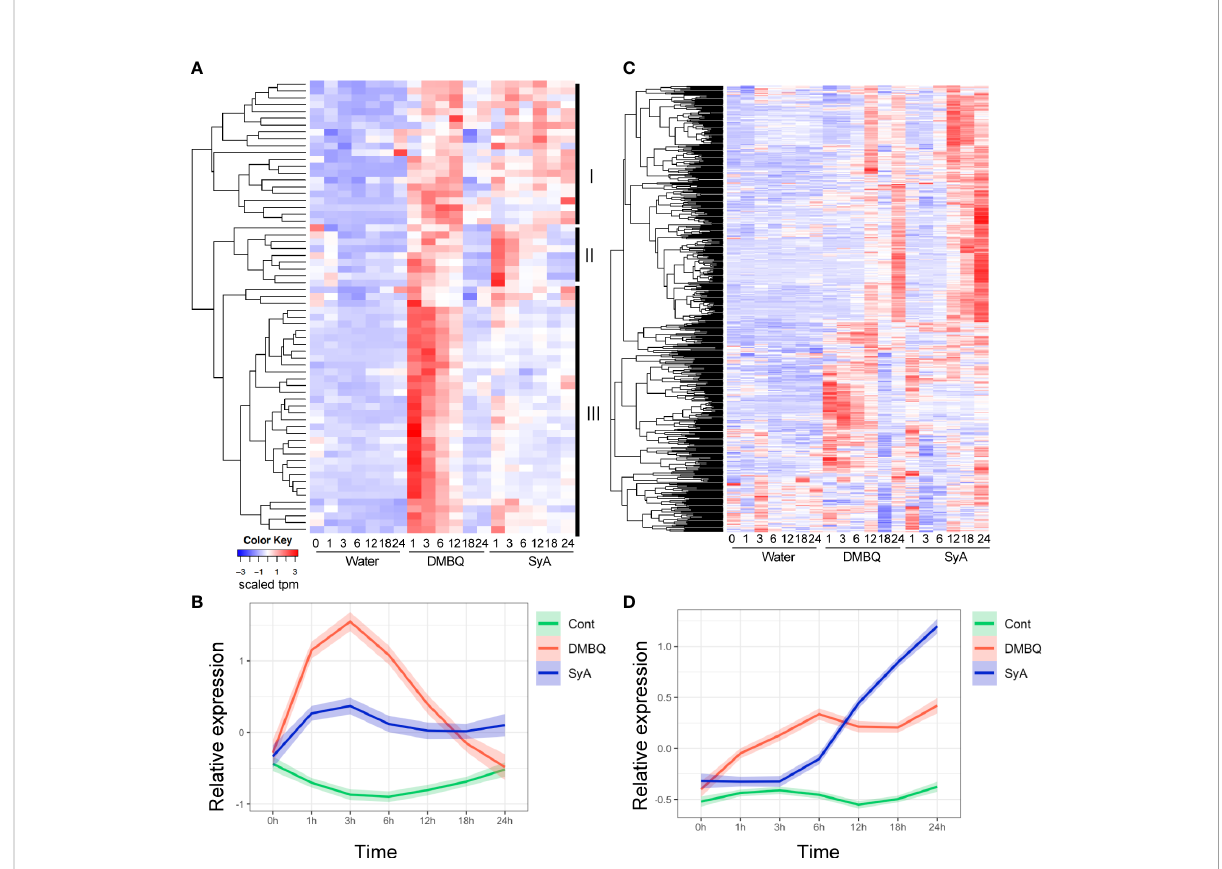
FIGURE 5 Expression patterns for 3-h and 24-h commonly upregulated contigs after DMBQ or SyA treatments. (A) Heatmap of relative expression values for 66 genes commonly upregulated by DMBQ or SyA at 3 h after treatment. Hierarchical clustering divide these transcripts into three large clusters I, II and III as labeled at the right. (B) The scaled expression values (tpm) of the 3-h commonly upregulated genes are shown by LOESS regression. (C) Heatmap of relative expression values for 534 genes commonly upregulated by DMBQ or SyA at 24 h after treatment. (D) The scaled expression values (tpm) of the 24-h commonly upregulated genes are shown by LOESS